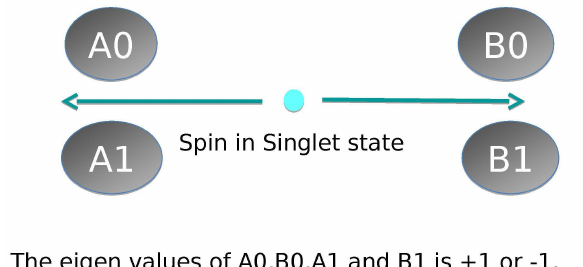
The eigen values of AO,BO,A1 and B1 is +1 or -1. Figure 1. Schematic diagram of Bell’s inequality example for a spin system. Here pictures are taken from